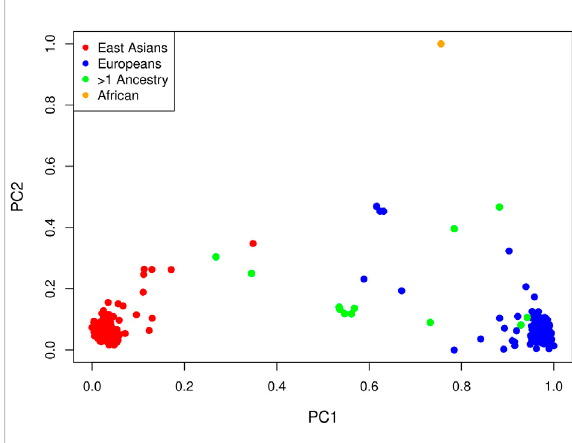
FIGURE 3 Projections of each affected child onto the fi rst two PCs by self-reported ancestry: red = East Asian (234 trios), blue = European (214 trios), orange = African (one trio) and green = multiple ancestry/other (13 trios). Each PC has been shifted and scaled so that a PC1 value near zero corresponds to a hypothetical East Asian and a PC1 value near one corresponds to a hypothetical